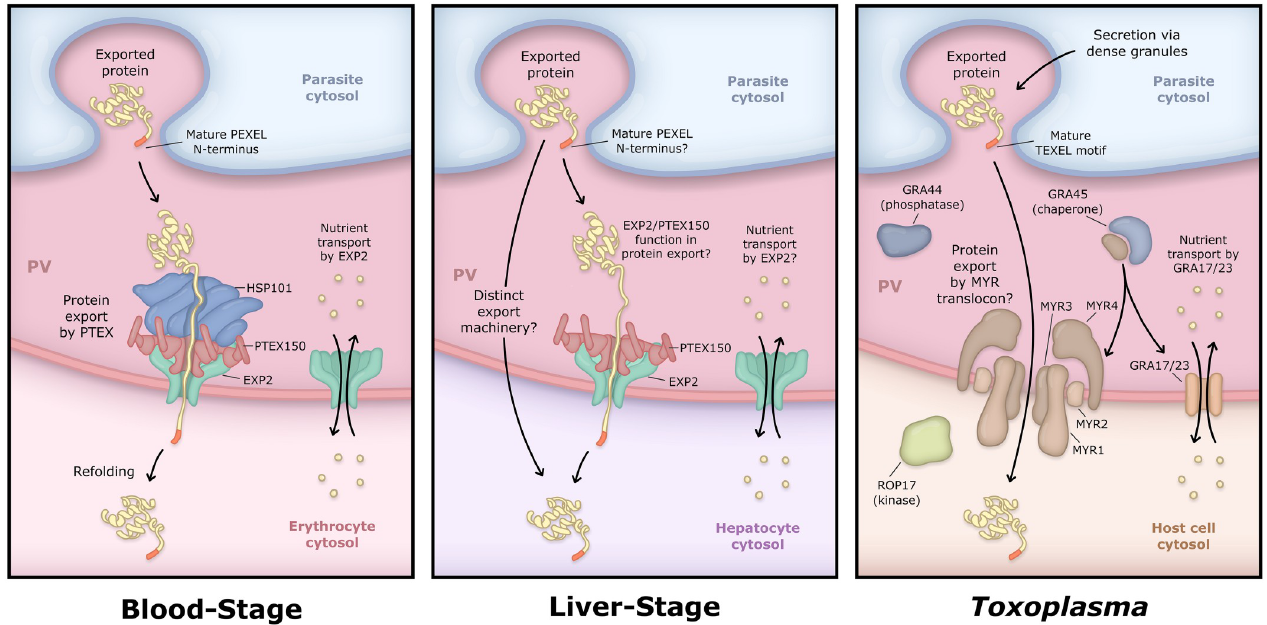
Fig 5. Comparison of PV transport in Plasmodium blood and liver-stages and Toxoplasma . In contrast to the blood-stage, HSP101 has not been detected in the liver-stage PV, suggesting fundamental differences in the export mechanism within the hepatocyte. While EXP2 has recently been implicated in sporozoite invasion of hepatocytes, it is unknown whether EXP2 and/or PTEX150 contribute to protein export or small molecule transport during intrahepatic development. While EXP2 orthologs GRA17 and 23 are required for small molecule transport across the Toxoplasma PVM, they are not involved in the export of dense granule effector proteins from the PV. Instead, a distinct set of proteins are required for export of these effectors including the membrane proteins MYR1–4 which are believed to form a novel translocon (possible MYR translocon organization shown here is purely speculative for purposes of illustration). Export also requires the putative phosphatase GRA44 and the chaperone GRA45, which may insert the MYR proteins into the PVM. Export additionally depends on the activity of ROP17, a kinase injected from the rhoptries into the host cytosol during invasion. ROP17 acts at the PV surface but the phosphorylated target(s) is not known. TgPPMC3, an additional phosphatase localized to the PV and involved in the export of a subset of effectors, is not represented in the cartoon. Processing of a TEXEL motif by the aspartic protease ASP5 is important for export of some Toxoplasma dense granule effectors while others lack the motif and are not processed by ASP5, although their export still requires ASP5 for unclear reasons. In contrast to the Plasmodium blood- stage, most ASP5 substrates are non-exported PV resident proteins, including MYR1, GRA44, and GRA45. EXP2, exported protein 2; HSP101, heat shock protein 101; PTEX, Plasmodium Translocon of EXported proteins; PV, parasitophorous vacuole; PVM, PV membrane; TEXEL, Toxoplasma EXport ELement.